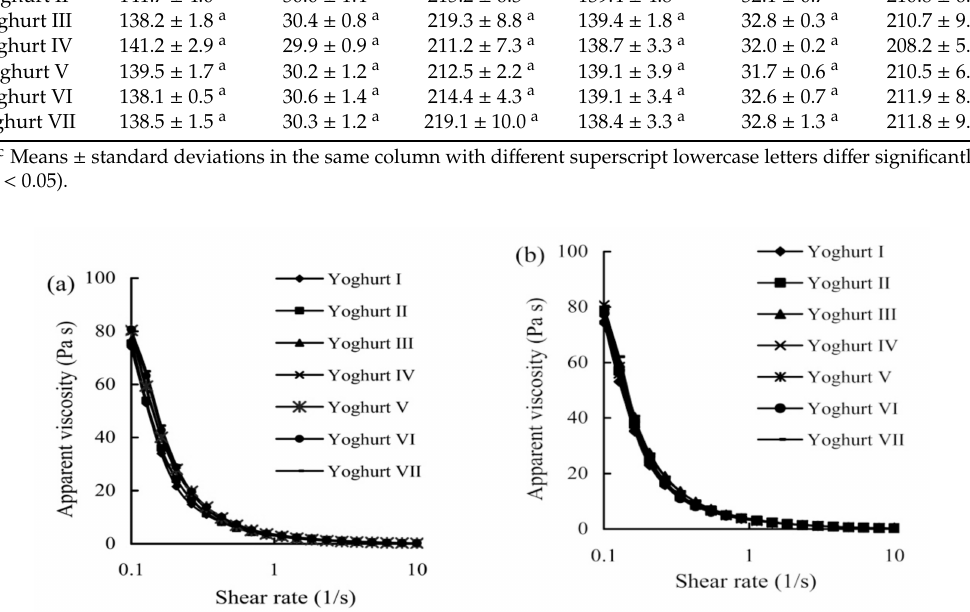
Figure 1. Apparent viscosity values of Yoghurts I–VII stored for 1 day ( a ) or 21 day ( b ). Yoghurt I is the control yoghurt without prebiotics fortification. Yoghurts II, IV, and VI are the yoghurt samples fortified with inulin, iso-malto-oligosaccharides, and xylo-oligosaccharides of 3 g / kg milk, while Yoghurts III, V, and VII are the yoghurt samples fortified with inulin, iso-malto-oligosaccharides,